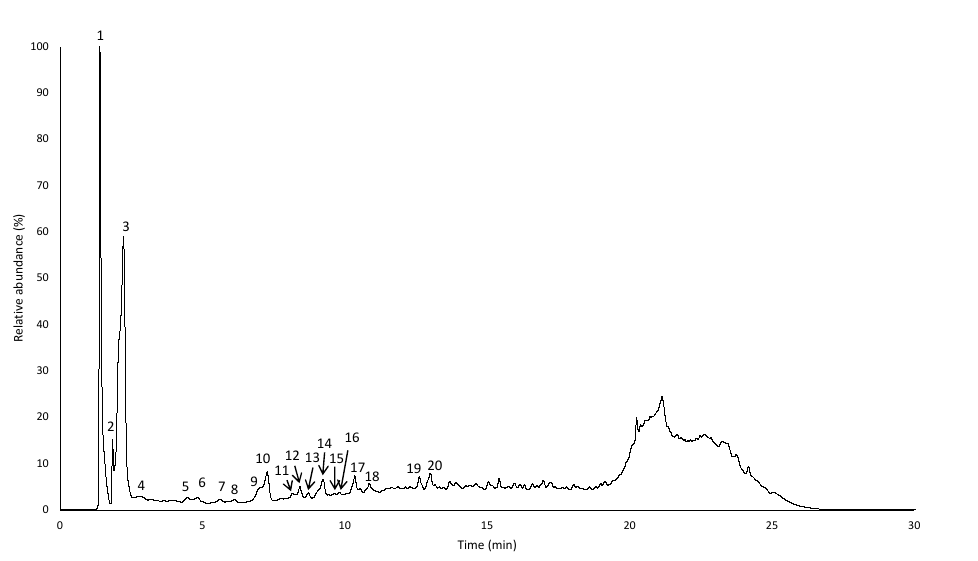
Figure 3. Chromatographic profile of the ethyl acetate fraction of S. vulgare extract at 280 nm. Peaks marked with numbers correspond to the tentatively identified compounds represented in Table 5. Table 5. Tentative assignment of the compounds present in the ethyl acetate fraction of S. vulgare extract analyzed by LC-ESI-MS/MS.